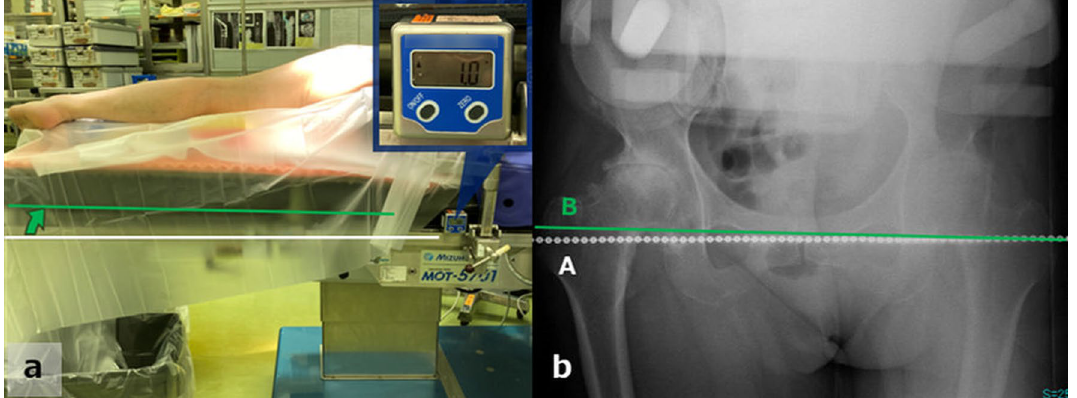
Figure 4. ( a ) The operating table was tilted 1° cranially, in this case, to adjust the pelvis to the functional pelvic plane. ( b ) This tilting angle (pelvic tilt in the coronal plane) is measured as an angle formed by a perpendicular line to the floor (a hanging chain, line A) and a teardrop line (line B).